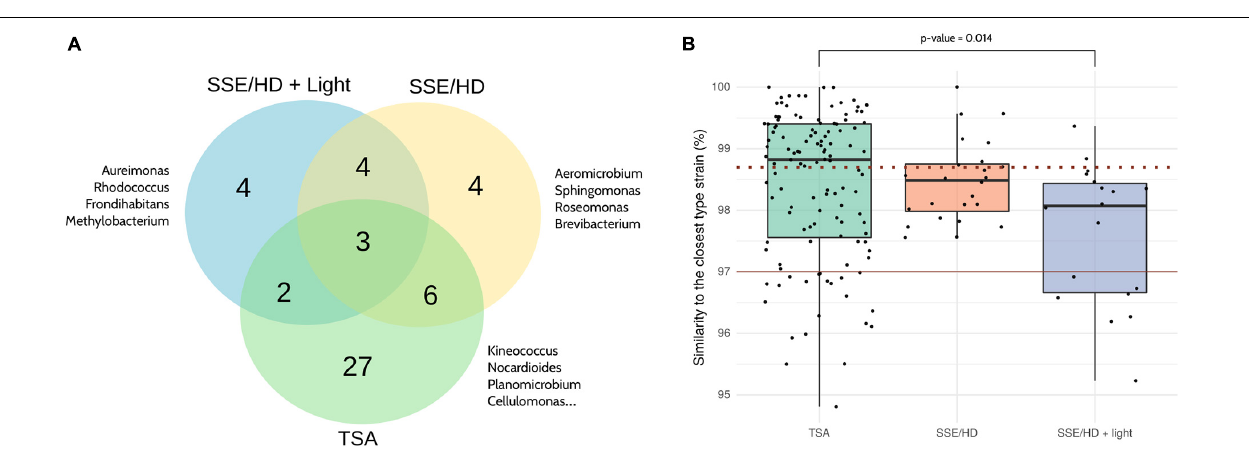
FIGURE 6 | Comparison of the different culture conditions. (A) Venn diagram showing the bacterial genera isolated from each culture condition. The complete list of genera isolated from each condition can be found in Supplementary Table 6 . (B) Percentage of similarity shared by each strain and its closest phylogenetic neighbor according to partial 16S rRNA gene sequencing. The dotted and the solid red lines are drawn on 98.7 and 97% of similarity, respectively. The Mann–Whitney U test was applied for comparing between groups, and p -values were corrected using the Benjamini-Hochberg method. Only significant results are highlighted. Note that all the identifications were obtained by partial 16S rRNA gene Sanger